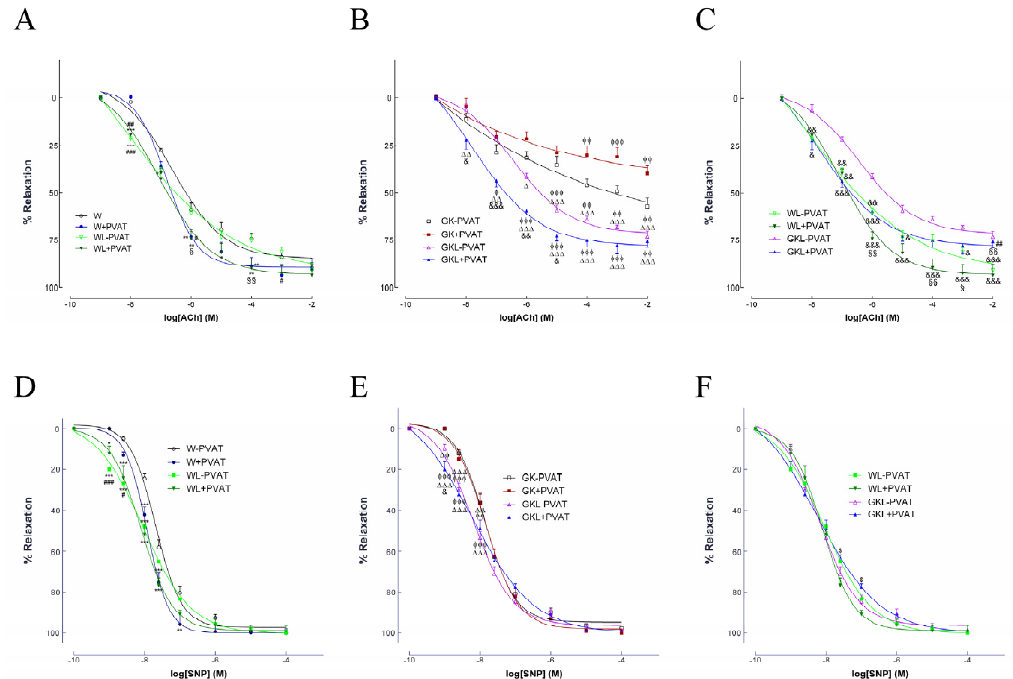
Figure 2. Effects of luteolin on vascular responses to acetylcholine (ACh, panel A – C ), and sodium nitroprusside (SNP, panel D – F ) in aortas of normal Wistar (W) and diabetic Goto-Kakizaki (GK) rats mounted with or without perivascular adipose tissue (PVAT). ( A , B ) Endothelium-dependent vasodilation in aortic rings in the absence ( − PVAT) or presence of PVAT (+PVAT) was assessed in W (panel A ) and GK rats (panel B ) with or without luteolin treatment. ( C ) Comparison of endothelium-dependent vasodilation in aortic rings in W and GK rats treated with luteolin. ( D ). Vasodilator response to SNP in aortas of W (panel D ) and GK (panel E ) rats. Endothelium-independent vasodilation in aortic rings in the absence ( − PVAT) or presence of PVAT (+PVAT) was assessed in W and GK with or without luteolin treatment (panel D – F ). ( F ) Comparison of endothelium-independent vasodilation in aortic rings in W and GK rats treated with luteolin. Data are expressed as mean ± SE ( n = 10). * p < 0.05, ** p < 0.01, *** p < 0.001 vs. W-PVAT group; # p < 0.05, ## p < 0.01, ### p < 0.001